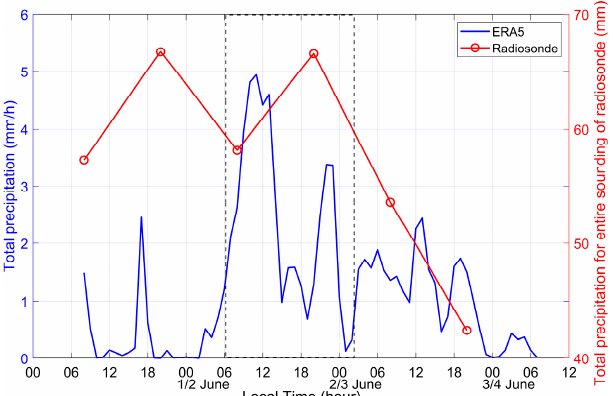
Figure 1. Total precipitation of the rainfall per hour in Chongyang available from ERA 5 data (blue curve) and total precipitation for the entire sounding of the Wuhan radiosonde (red curve) from 8:00 LT on 1 June to 7:00 LT on 4 June 2015. The black dashed box illuminates the main rainstorm duration.